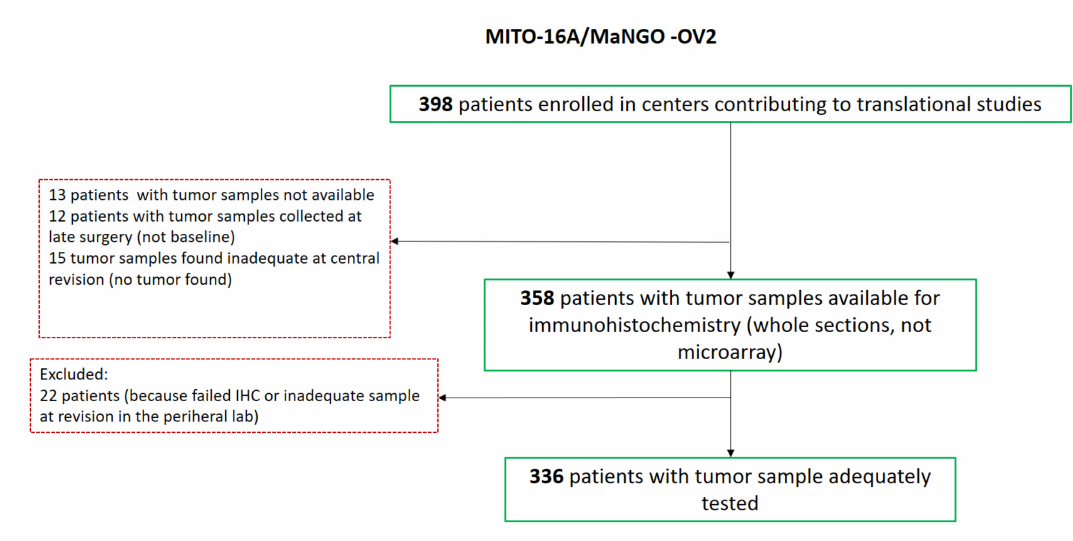
Figure 1. Consort of the